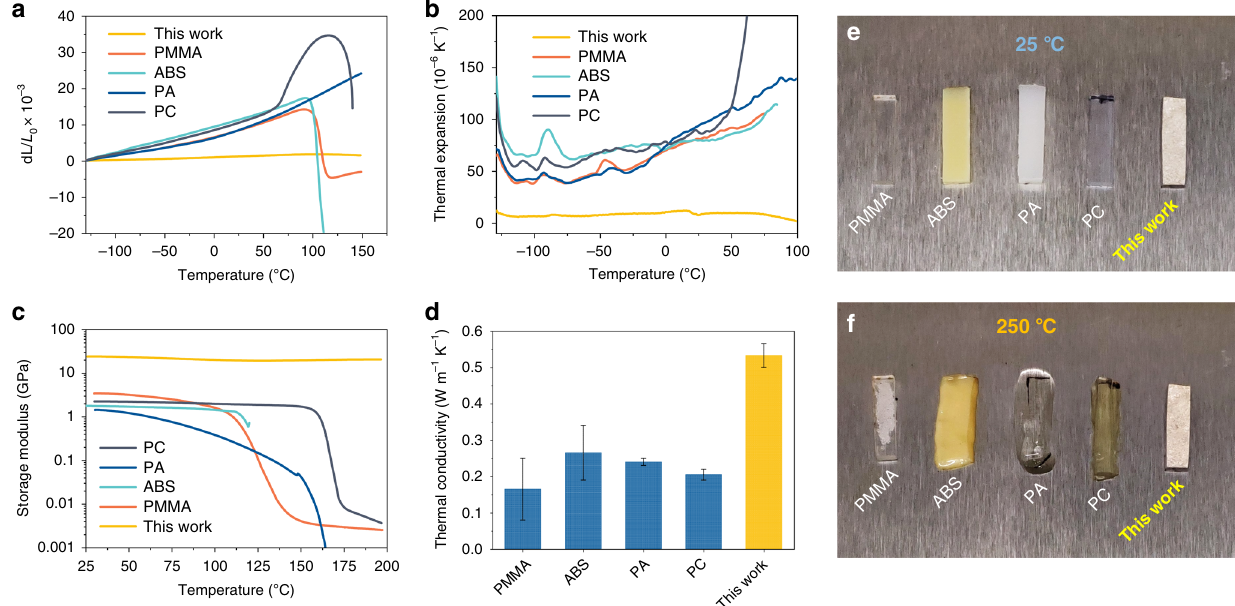
Fig. 4 Comparison of thermal properties of all-natural bioinspired structural material with widely used plastics. a Comparison of thermal expansion of the all-natural bioinspired structural material with widely used petroleum-based plastics. b Comparison of coef fi cient of thermal expansion (CTE) of the all- natural bioinspired structural material with widely used petroleum-based plastics. c Comparison of storage modulus of the all-natural bioinspired structural material with widely used petroleum-based plastics. d Comparison of thermal conductivity of the all-natural bioinspired structural material with widely used petroleum-based plastics 31 . Error bars represent standard deviation. e , f Thermal stability experiment. Comparison of the all-natural bioinspired structural material with widely used petroleum-based plastics at e 25 °C and f 250 °C. Compared to 25 °C, petroleum-based plastics have already fully softened at 250 °C, while all-natural bioinspired structural material still shows no visible change. PMMA polymethyl methacrylate, ABS acrylonitrile butadiene styrene, PA polyamide, PC polycarbonate.